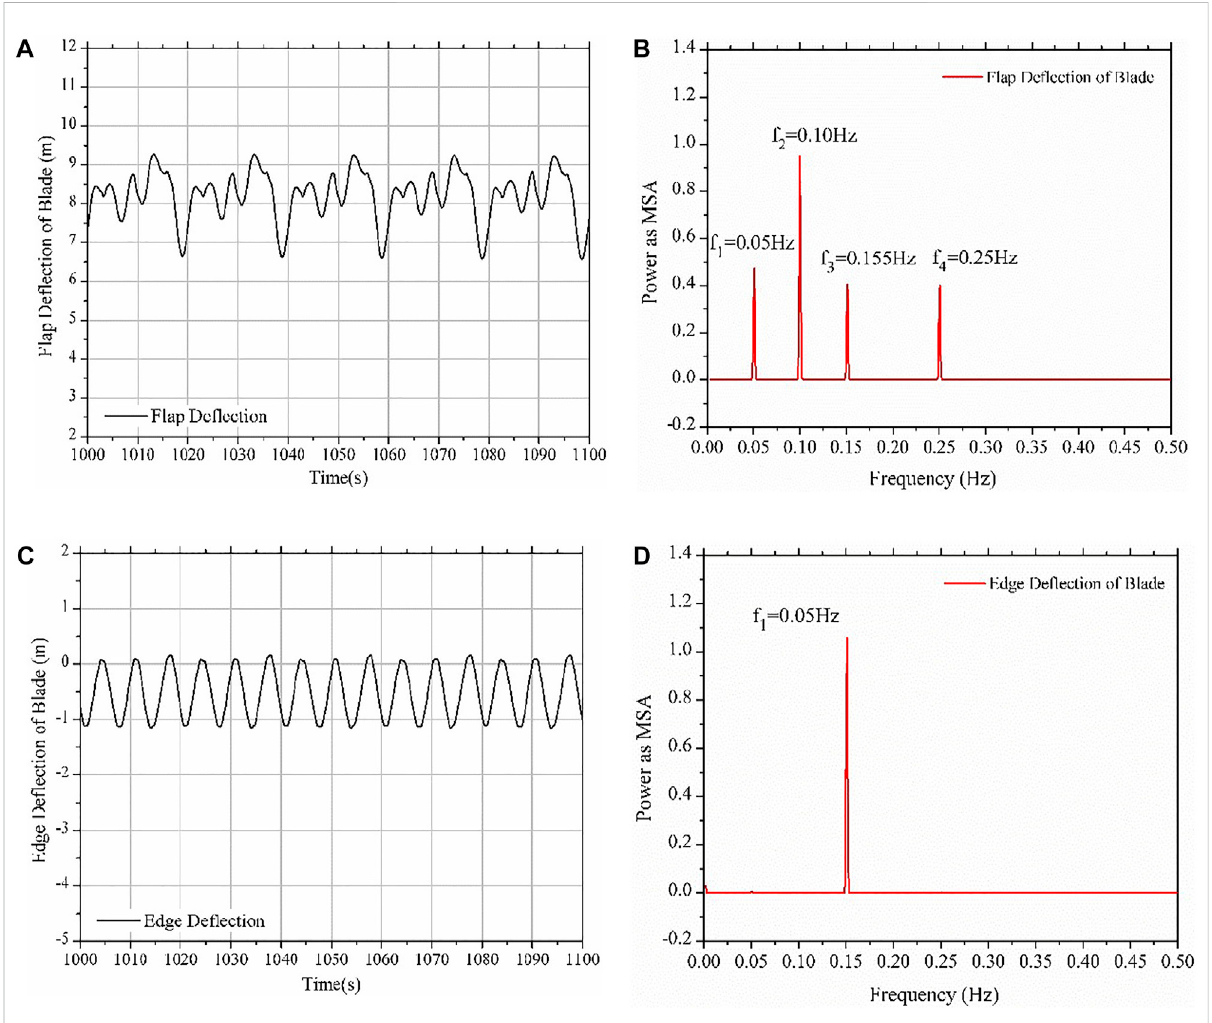
FIGURE 9 De fl ections under different regular waves: (A) the time history of the fl ap de fl ection; (B) the power spectrum of the fl ap de fl ection; (C) the time history of the edge de fl ection; (D) the power spectrum of the edge de fl ection.